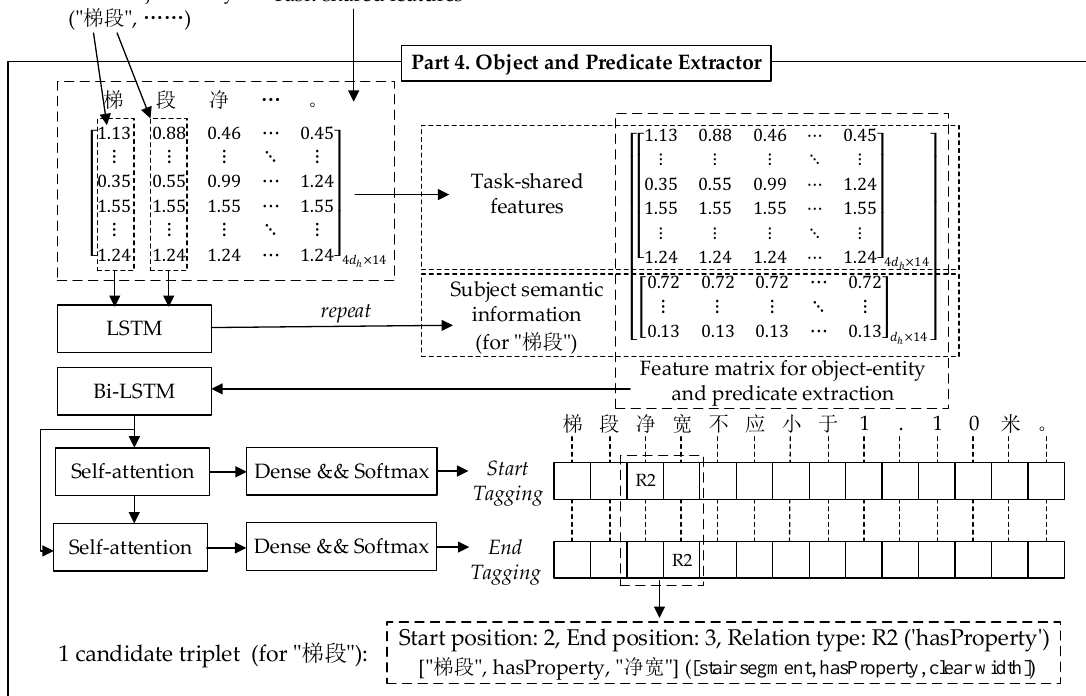
Figure 4. The extraction of object entities and predicate relations. In this figure, the identified subject entity “ 梯 段 ” (stair segment) is taken as an